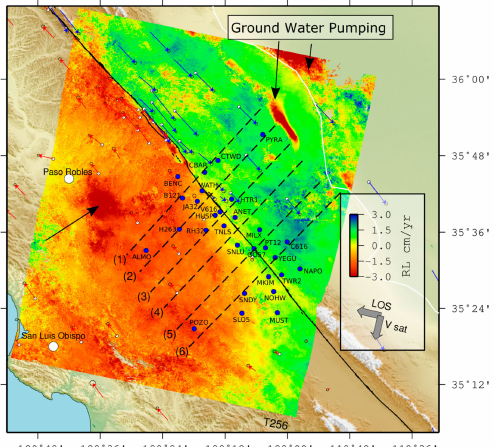
Figure 2. The 2005–2010 interferograms stack used in this study, the across-fault profiles (numbered from 1 to 6, dashed lines) at the location of the Cholame section of the San Andreas Fault and the SGPS network stations, locations, and names (blue circles) are presented here. The stack is composed by 43 interferograms computed from images acquired by Envisat-ASAR and ERS2 between 2005–2010. The color scale gives the deformation velocity in fault right lateral geometry (RL). The ground deformations due to water pumping (or oil extraction) are indicated by black arrows (Paso Robles, Coalinga, San Joaquim